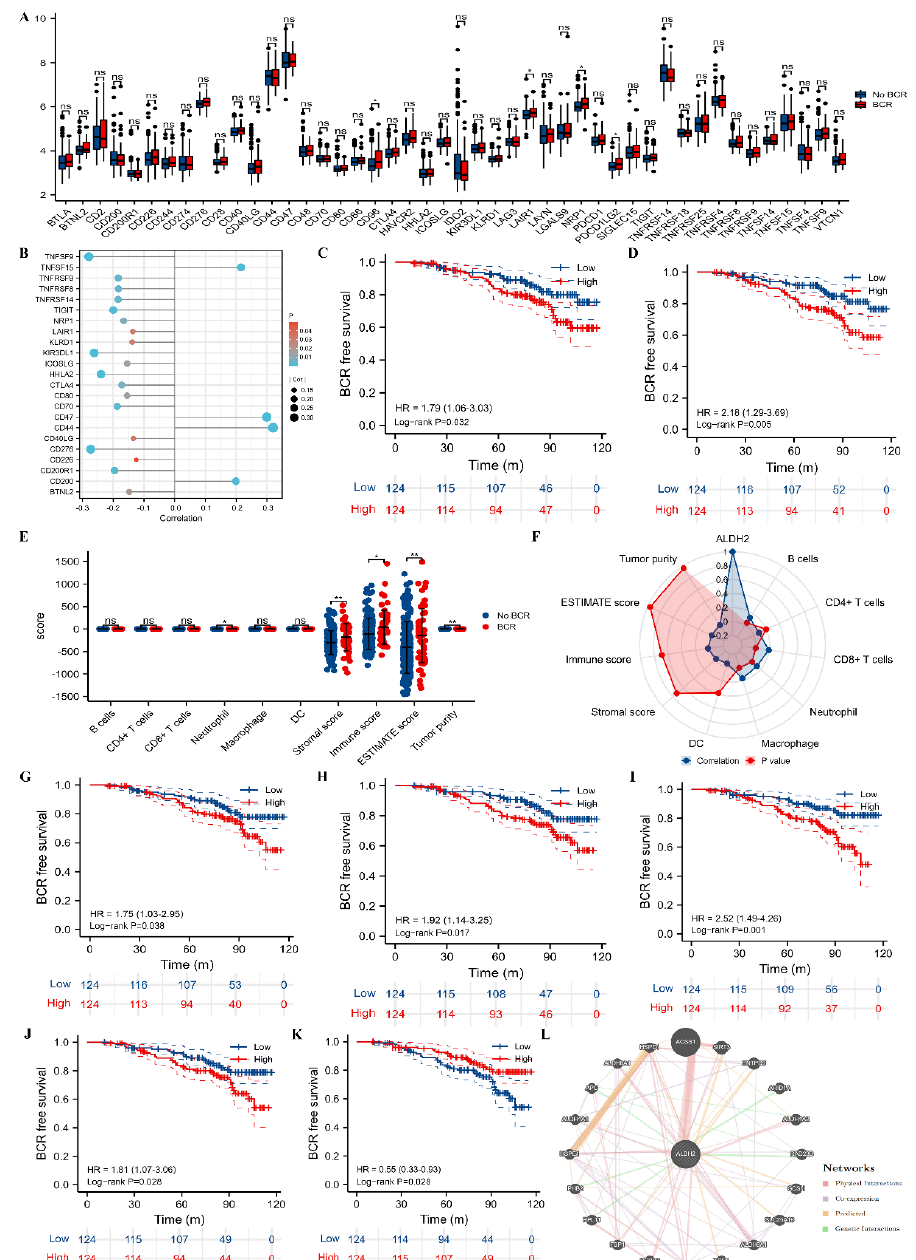
Figure 2. TME analysis and gene interaction with ALDH2. ( A ) Comparison between BCR and no BCR groups for the 46 immune checkpoints; ( B ) bubble plot showing correlations between ALDH2 and immune checkpoints with statistical significance; ( C ) Kaplan–Meier curve of CD96 for BCR-free survival; ( D ) Kaplan–Meier curve of NRP1 for BCR-free survival; ( E ) comparison between BCR and no BCR groups for the TME parameters; ( F ) radar plot showing correlations between ALDH2 and the TME parameters; ( G ) Kaplan–Meier curve of neutrophils for BCR-free survival; ( H ) Kaplan–Meier curve of immune score for BCR-free survival; ( I ) Kaplan–Meier curve of stromal score for BCR-free survival; ( J ) Kaplan–Meier curve of estimate score for BCR-free survival; ( K ) Kaplan–Meier curve of tumor purity for BCR-free survival; and ( L ) network plot showing genes interacted with ALDH2. TME = tumor immune microenvironment; BCR = biochemical recurrence.ns, 0.05; *,